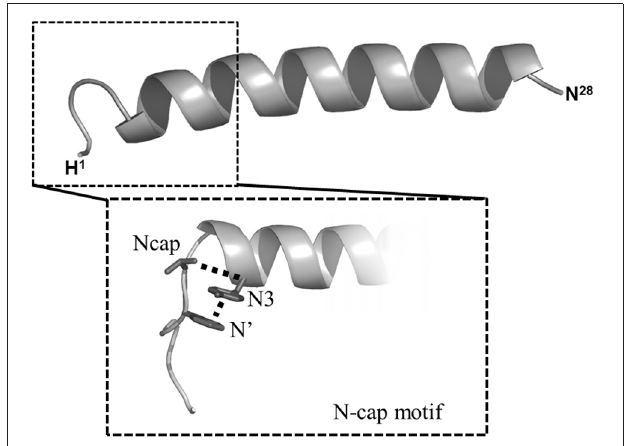
FIGURE 2 | NMR structure of VIP and representation of N-capping motif. Middle gray ribbon represents the average conformation of VIP structure. In magnified inset the N-capping motif is represented as (1) the hydrophobic interactions between side-chain groups of N’ and N3 residues (dashed lines); (2) the hydrogen bond between side chain of N-cap residue and backbone atom of N3 residue. See ref. Neumann et al. (2008) for details.